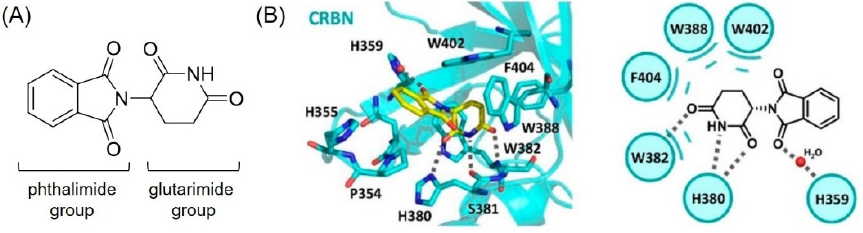
Figure 2. ( A ) Chemical structure of thalidomide composed of phthalimide and glutarimide groups. ( B ) Schematic illustrations of thalidomide binding mode to CRBN (PDB: 4CI1). Reprinted with permission from ref. [14] (Copyright 2021 American Chemical Society).